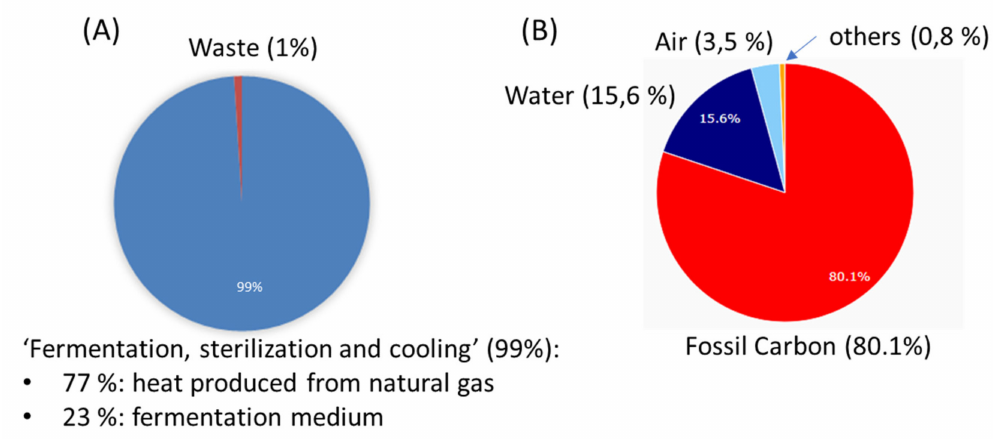
Figure 4. Evaluation of application technologies in terms of ecological footprint. Percentage share of the single process steps ( A ) and the di ff erent SPI-categories ( B ) to the overall footprint for S. plymuthica HRO-C48